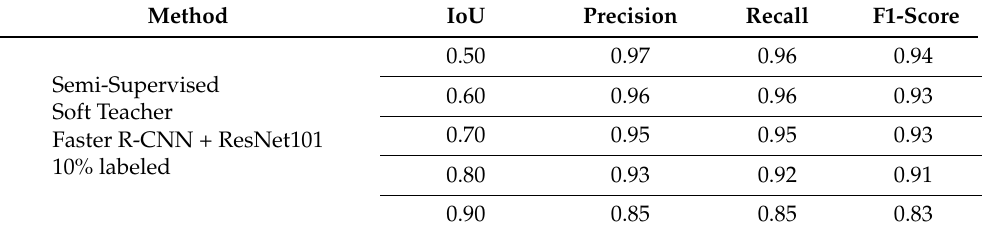
Table 8. A detailed representation of Precision, Recall and F1-Score at multiple IoUs. Our model is trained on 10% PubLayNet labeled data with Faster R-CNN and